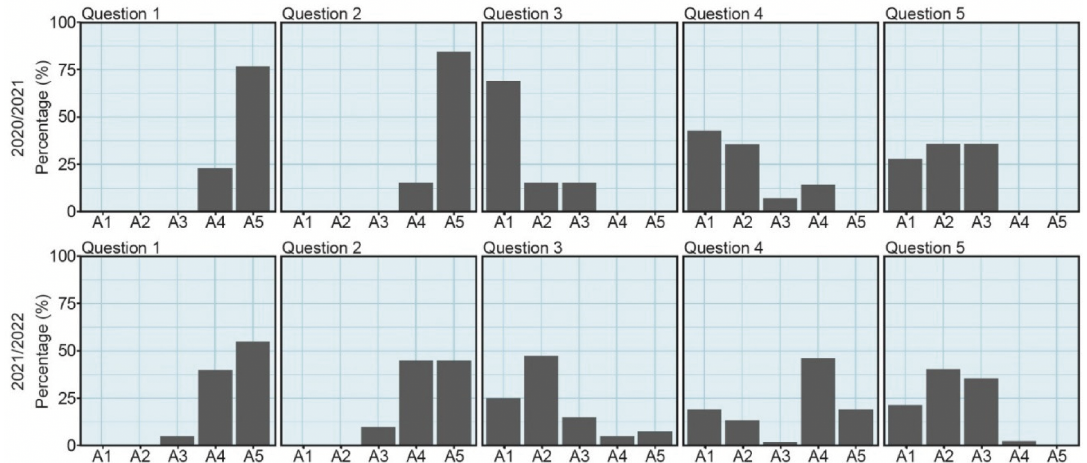
Figure 6. Percentage of answers given by students in assessment